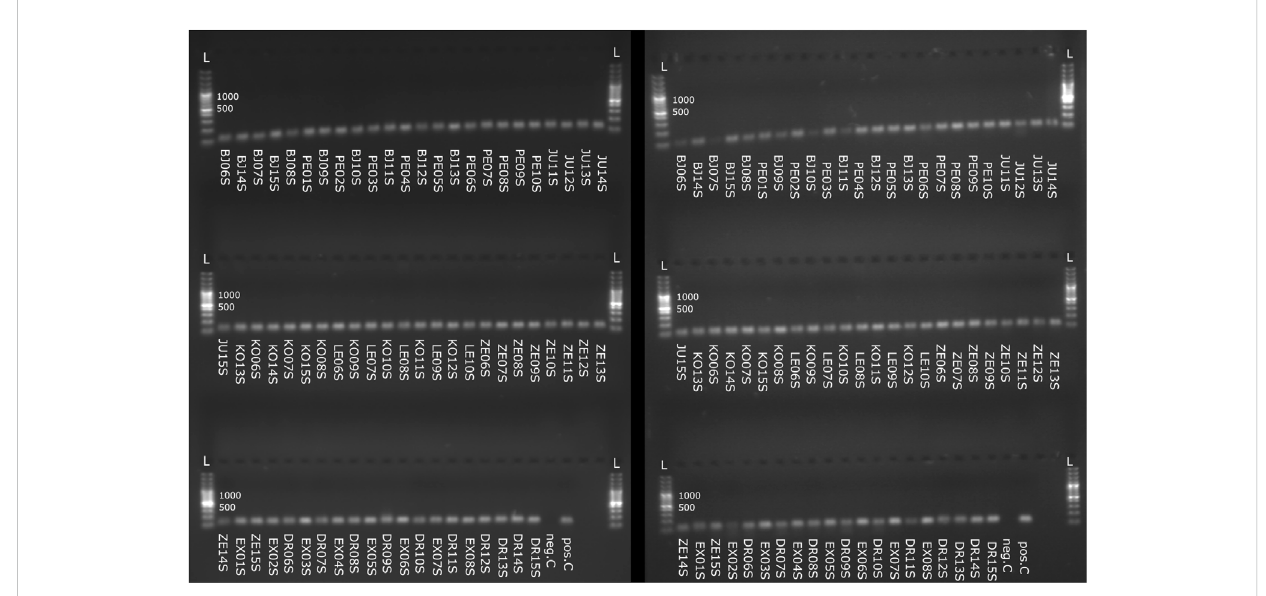
FIGURE 3 Agarose gel electrophoresis of ampli fi ed microsatellite loci from spermatheca samples. A07 microsatellite locus is presented on the left, A24 microsatellite locus is presented on right. L — 100 bp standard ladder, neg.C — Negative control, pos.C — Positive control.